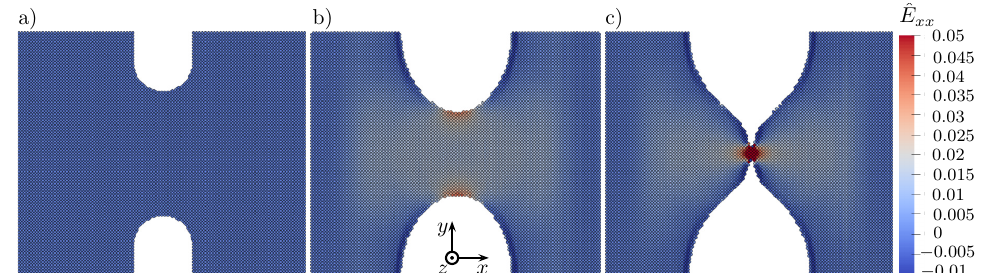
Figure 5. Discrete Green strain component ˆ E xx , evaluated by Equation (13) based on the discrete deformation gradient in Equation (21), at ( a ) the initial state, ( b ) an intermediate state and ( c ) the final state.